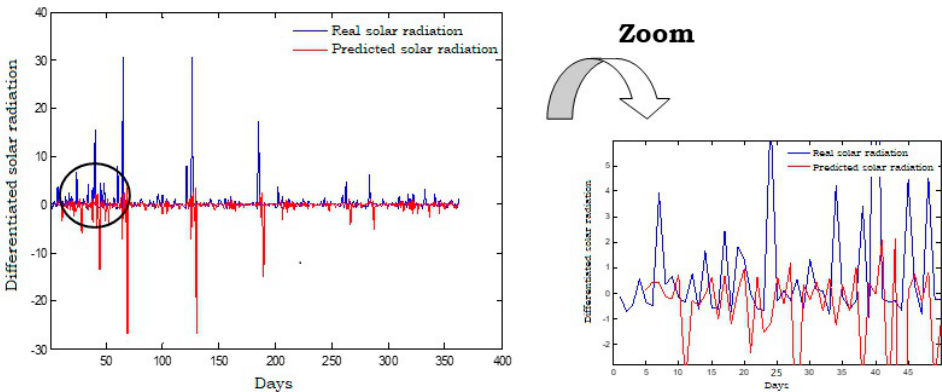
Figure 16. Solar radiation evolution prediction using the ARMA (4,4) model (daily radiation averages). Table 8. MSE, MAE, and RMSE of the prediction of solar radiation using the ARMA (4,4)